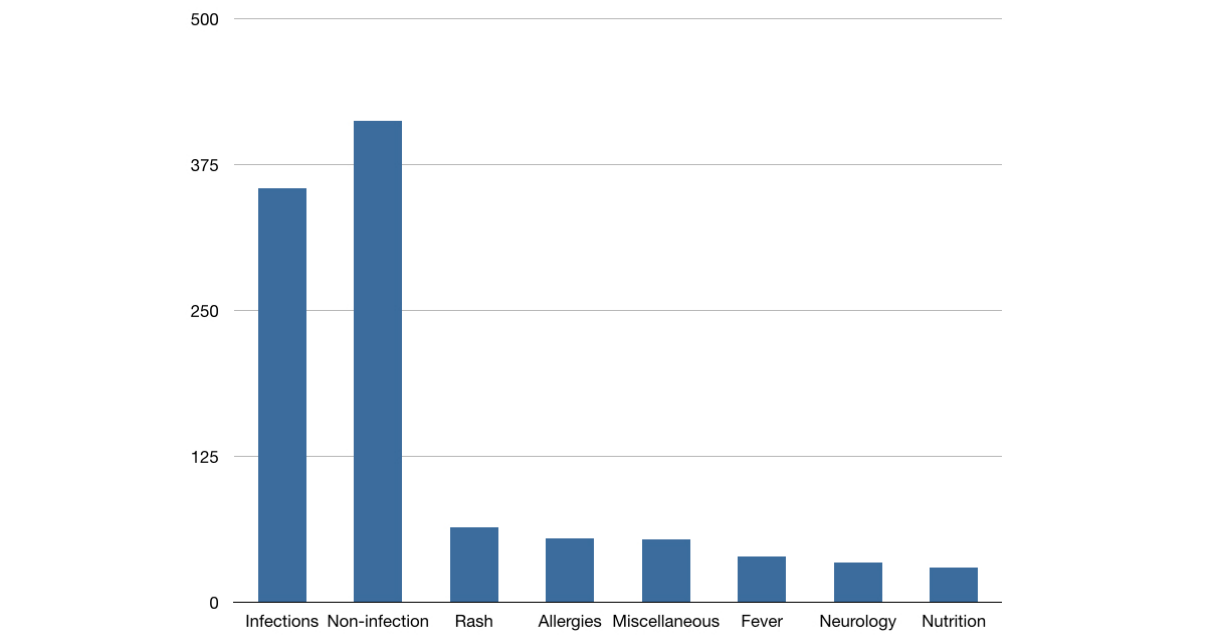
Figure 2. Number of questions categorized into topics (topics with less than 30 questions not shown).